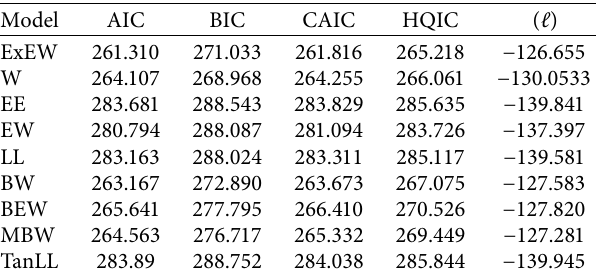
Table 8: The analytical performance measures for